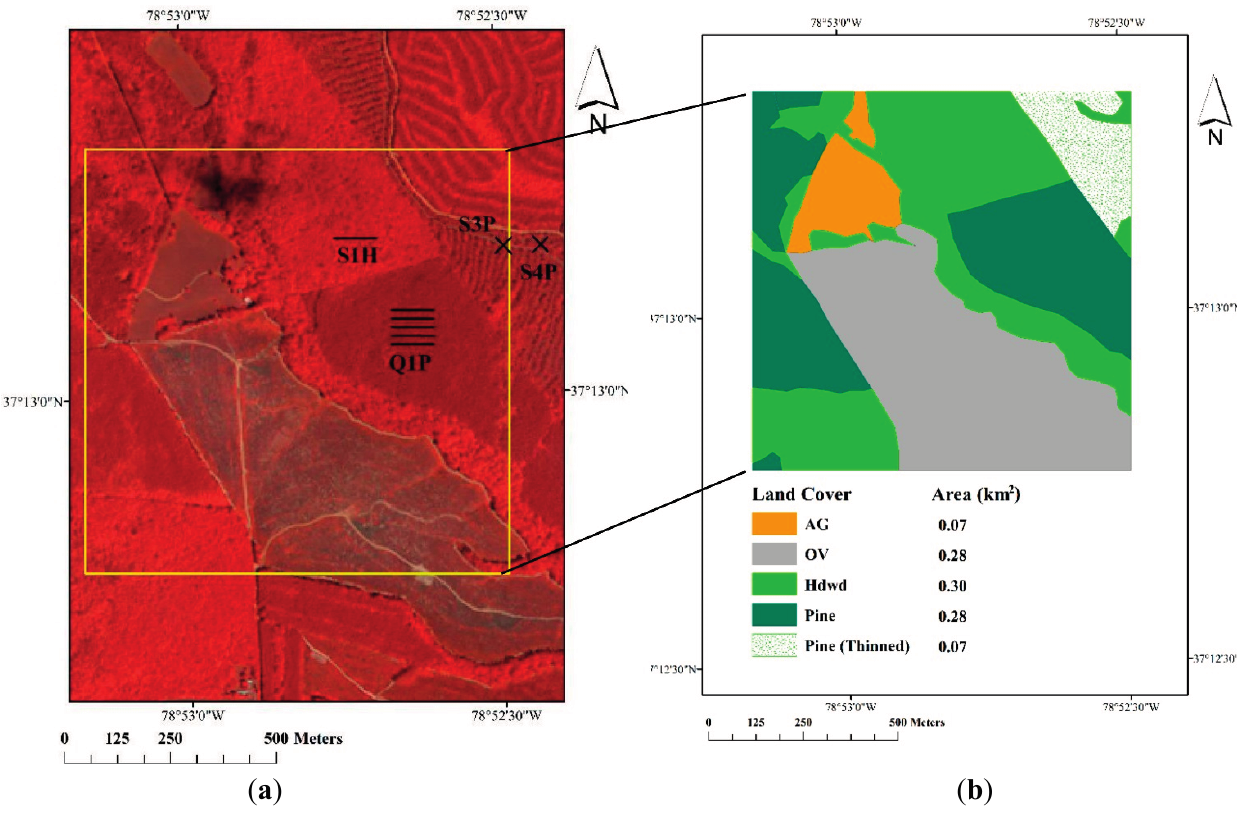
Figure 3. EPA_Appomattox 1-km 2 validation site. ( a ) Quadrant (Q1P) and sub-plot distributions (S3P, S4P, S1H) in the vicinity of the validation area (yellow box) are shown. Note: This image is an infrared false color composite of Ikonos imagery collected 24 May 2002 (coniferous—lower reflected IR (dark red); deciduous—lighter reflected IR (light red)) ( b ) Land cover reference map for 1-km 2 validation